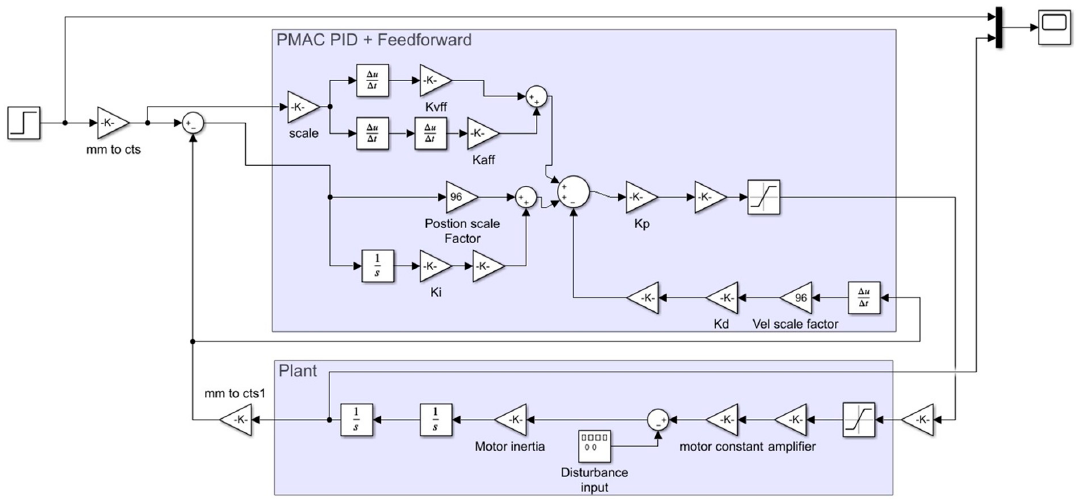
11 of 16 Figure 11. Structure of aerostatic bearing slideway control system. Simulink is a MATLAB-based graphical programming environment for modelling,